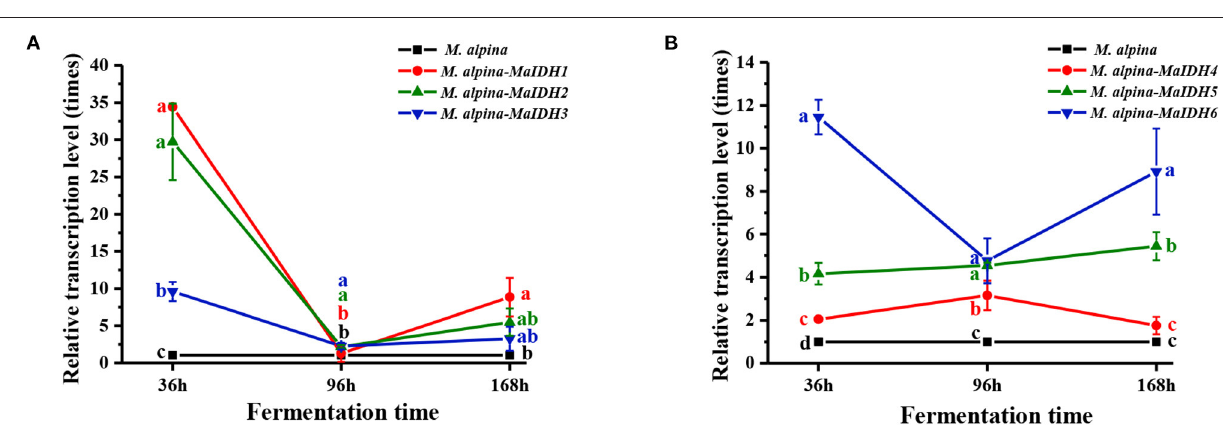
target gene, which was consistent with the theoretical